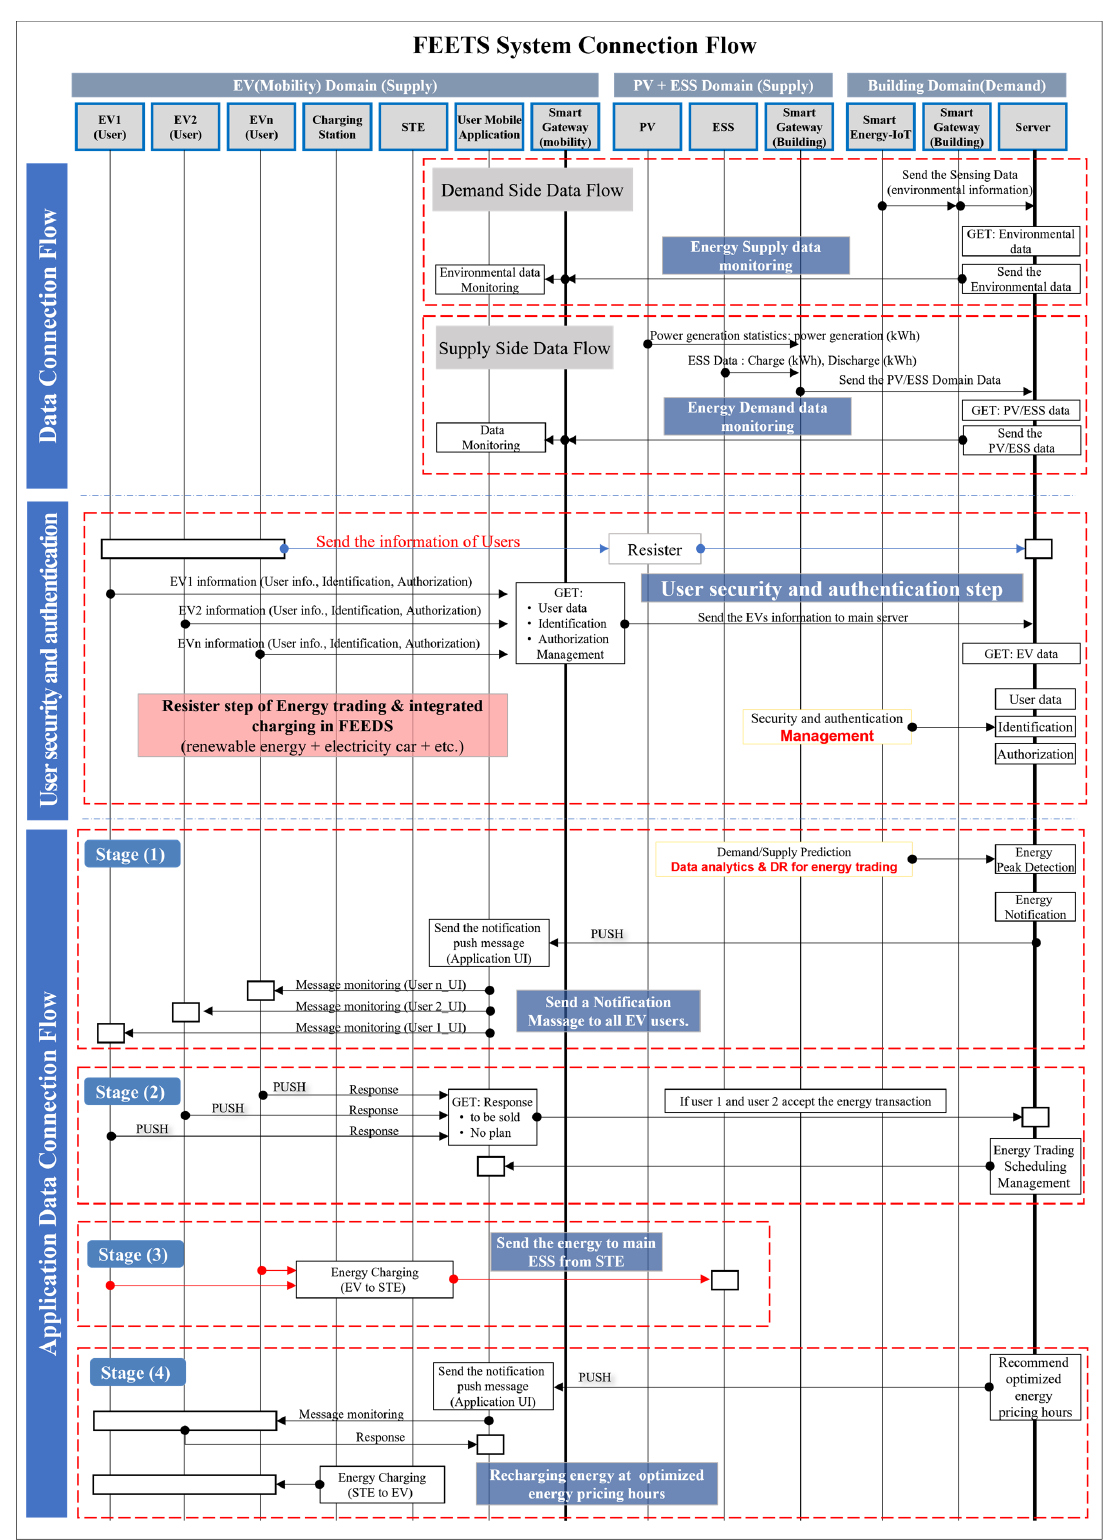
Figure 13. FEETS System configuration and energy, data connection flow.